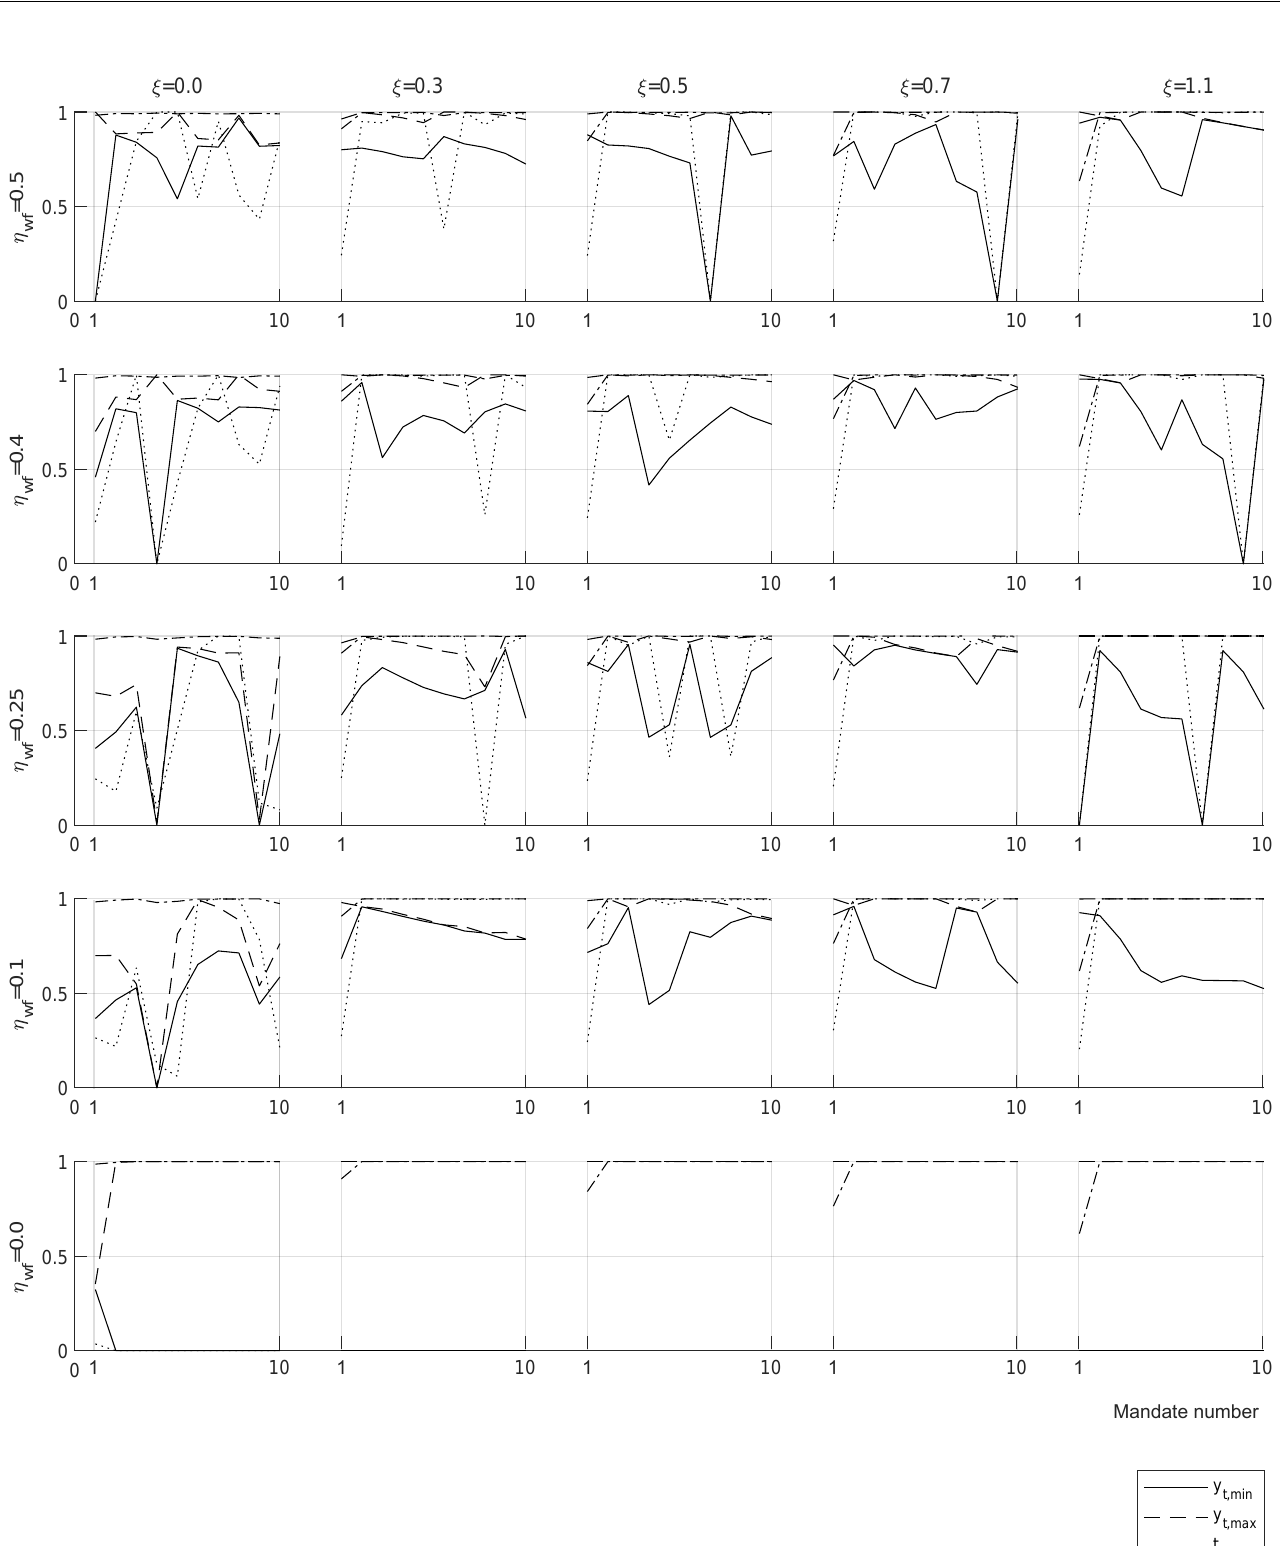
Figure A4. Tax policy evolution under yardstick vote during ten mandates for a series of welfare efficiency values η wf and tax disincentive ξ . Median criterion. Mandate length: 4 years. Vote constrained by